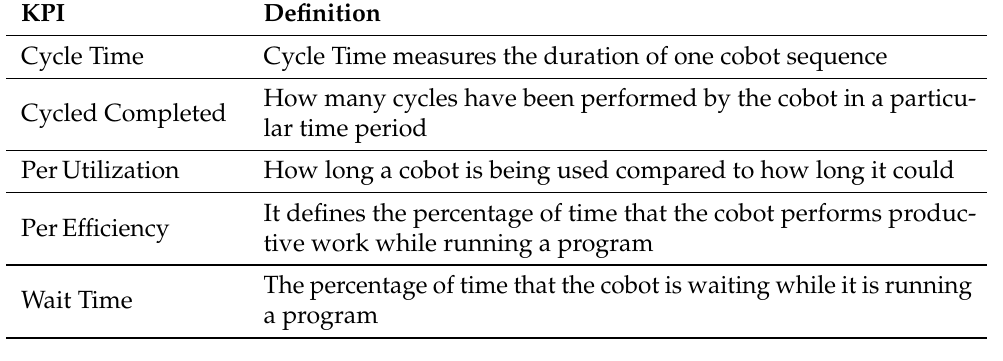
Table 6. KPIs referred to cobots.